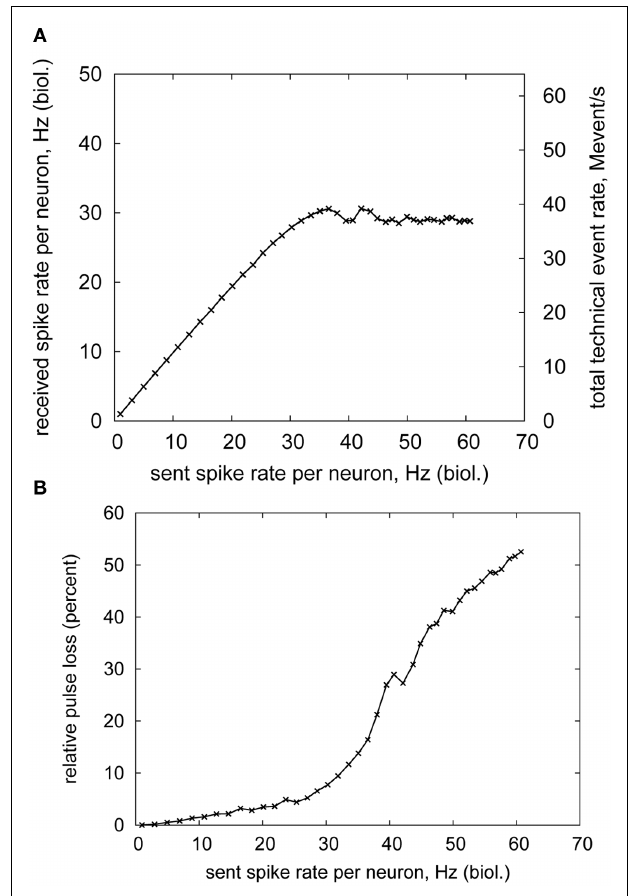
FIGURE 10 | Bandwidth measurement of a single FPGA–DNC–HICANN connection. (A) received spike rate (B) spike loss.